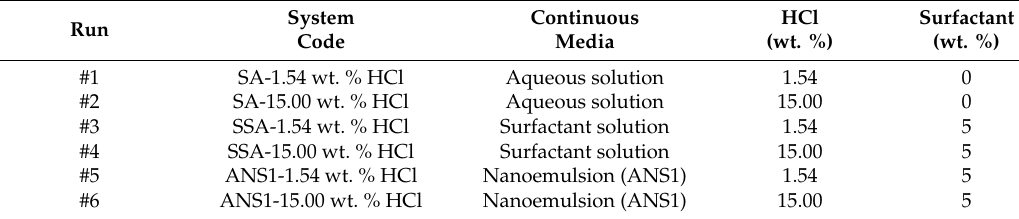
Table 4. Resume of the reactive systems used in the study of wettability alteration.